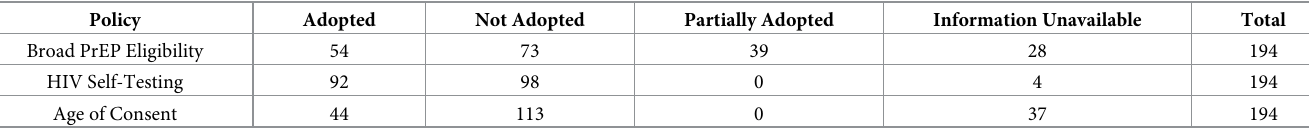
Table 1. Countries policy adoption status, Dec. 2021.